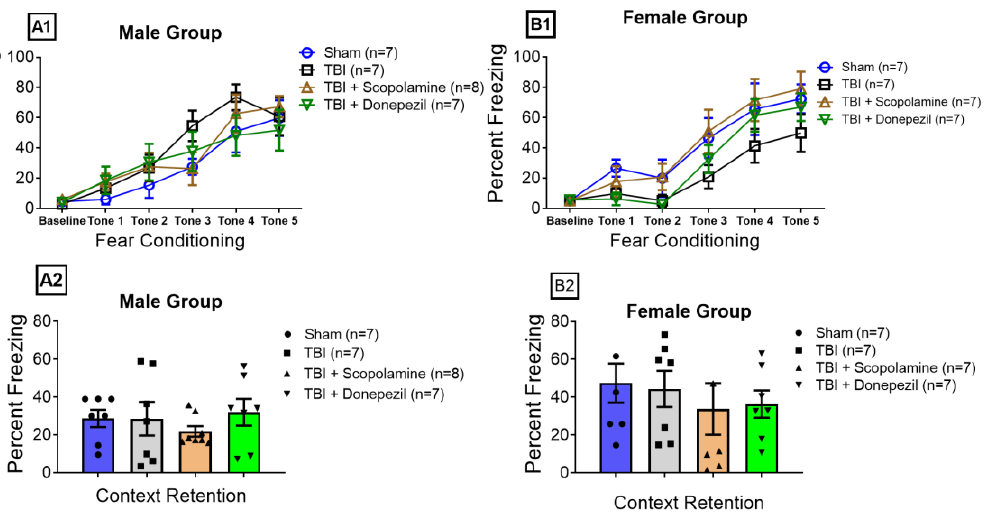
Figure 3. Effect of muscarinic modulation and TBI on fear memory retrieval. Graphs ( A1 , B1 ) represent the fear conditioning in the male and female mice, respectively. ( A2 , B2 ) show the retrieval of fear memory in the male and female mice, respectively, on day 12. Data are presented as mean ± SEM. TBI: traumatic brain injury; n : number of mice per group .